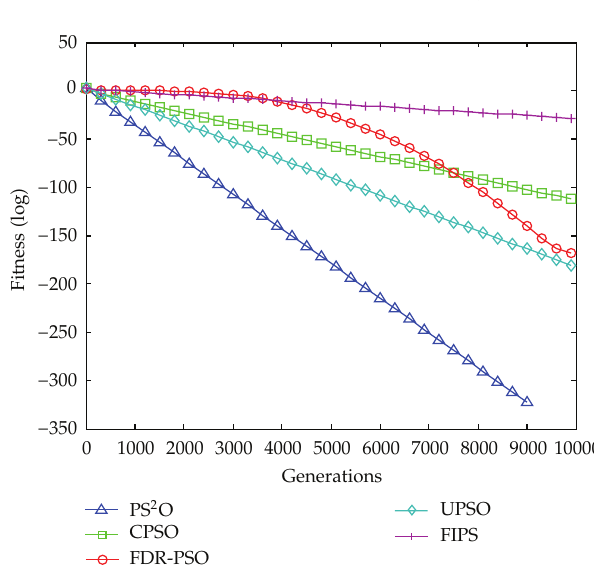
Figure 5: The median convergence results of Sphere function.